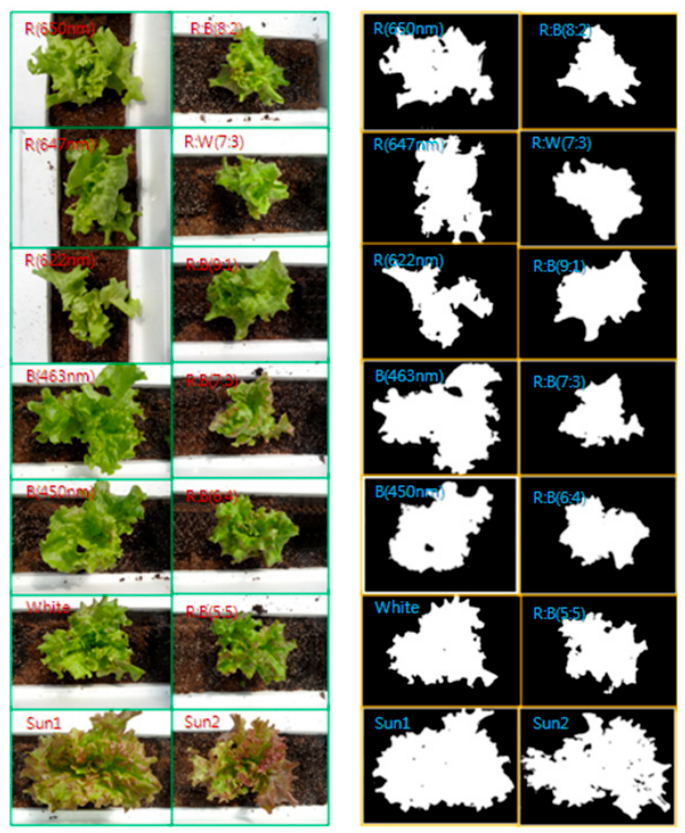
Figure 13. The crop’s image and its processed image according to light sources. Table 1 shows the physical measurement data and image data after cultivating the crop and Figure 14 shows the comparison between the image measurement data of different light source configurations. Table 1. Image measurements in accordance with arranged light sources and actual physical data measured.